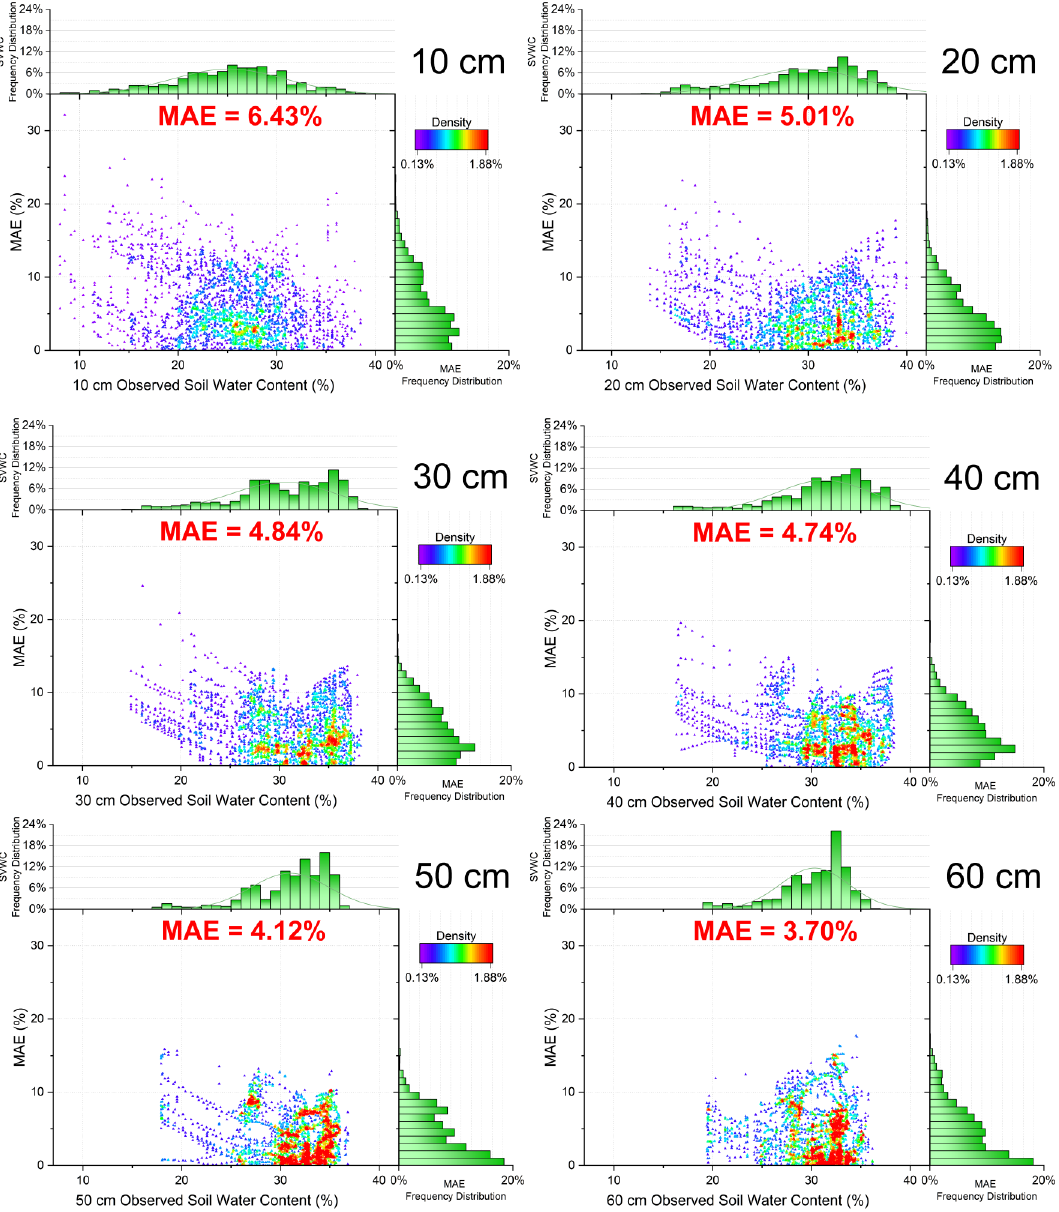
Figure 12. Distribution of the simulation errors for the Hydrus-1D model at different soil depths.